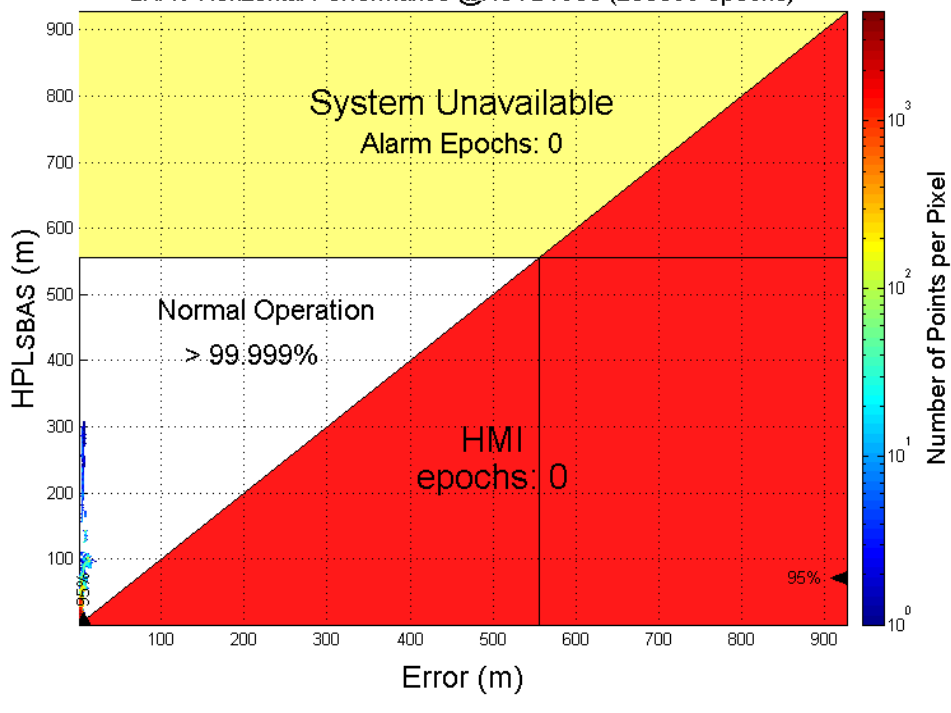
Figure 19. The number of satellites used in positioning solutions